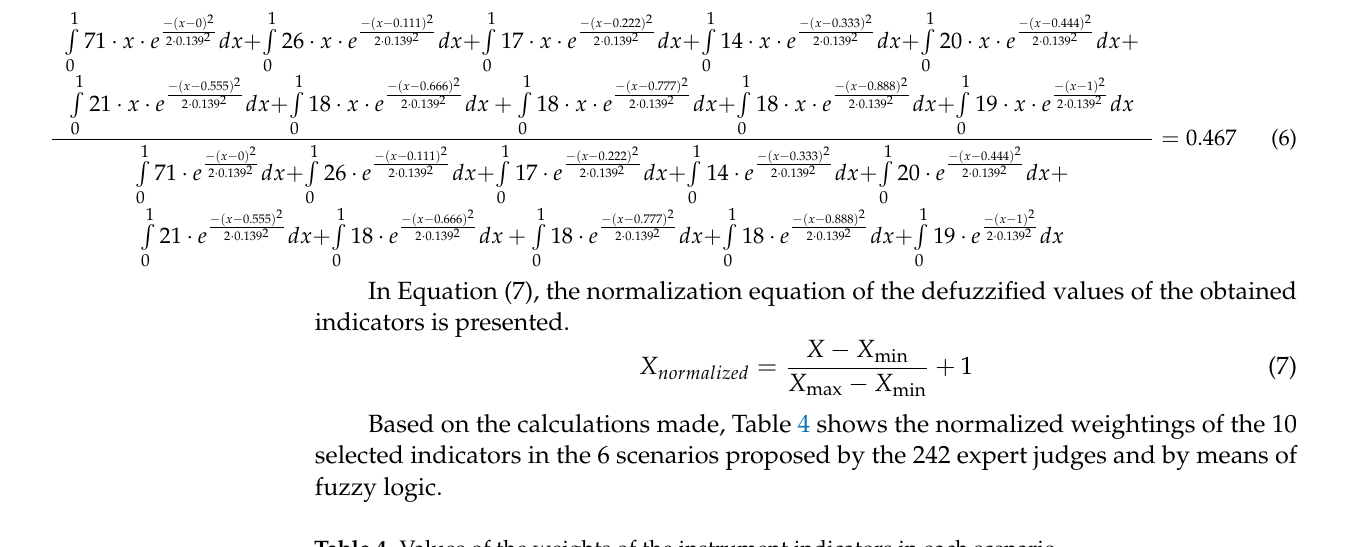
Table 4. Values of the weights of the instrument indicators in each